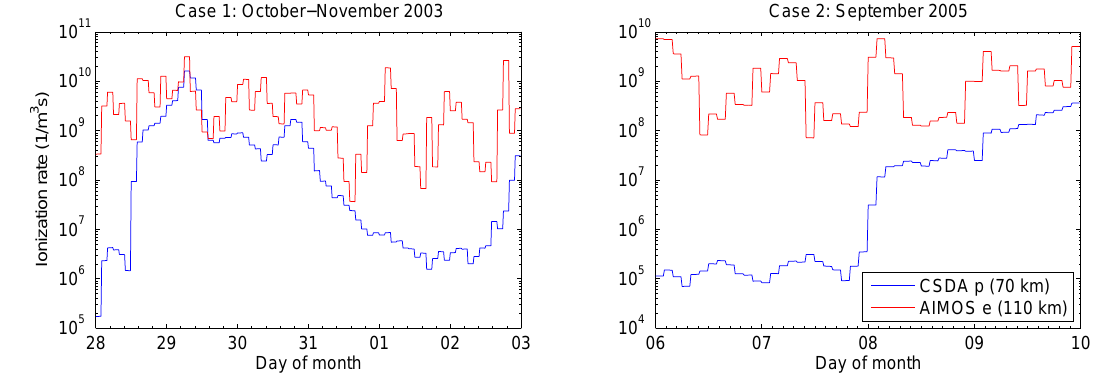
Figure 2. Calculated ionization rates due to protons (CSDA) and electrons (AIMOS) at 70 and 110km, respectively.